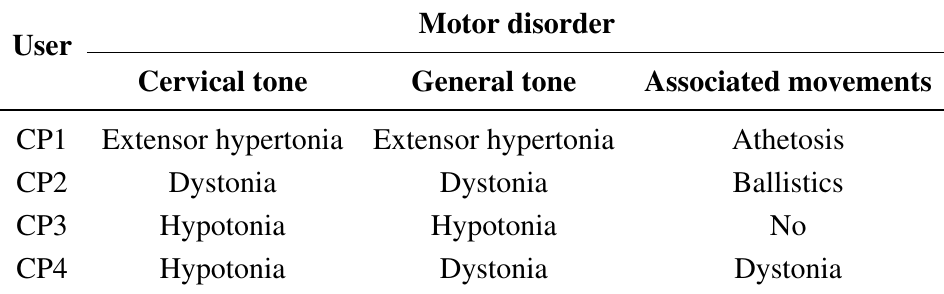
Table 2. Characteristics of subjects with